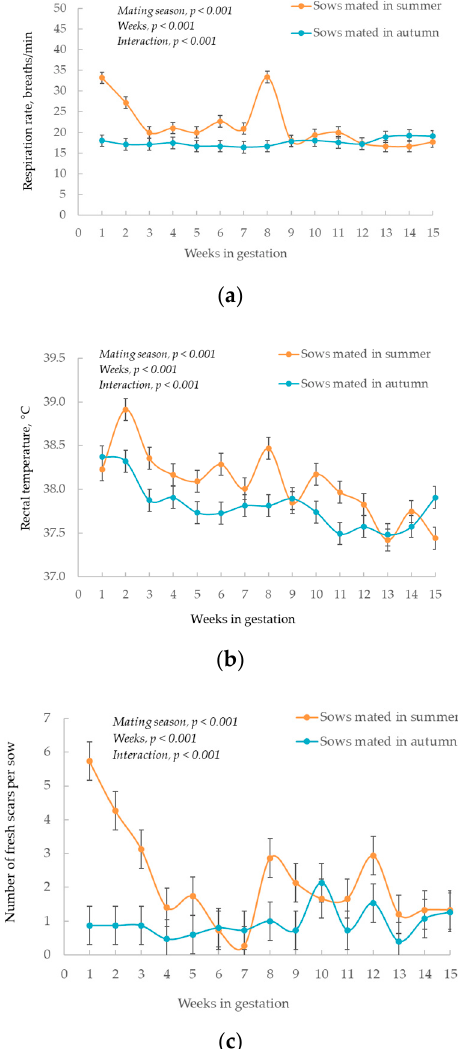
Figure 3. Respiration rate ( a ), rectal temperature ( b ), and skin injuries ( c ) of gestating sows mated